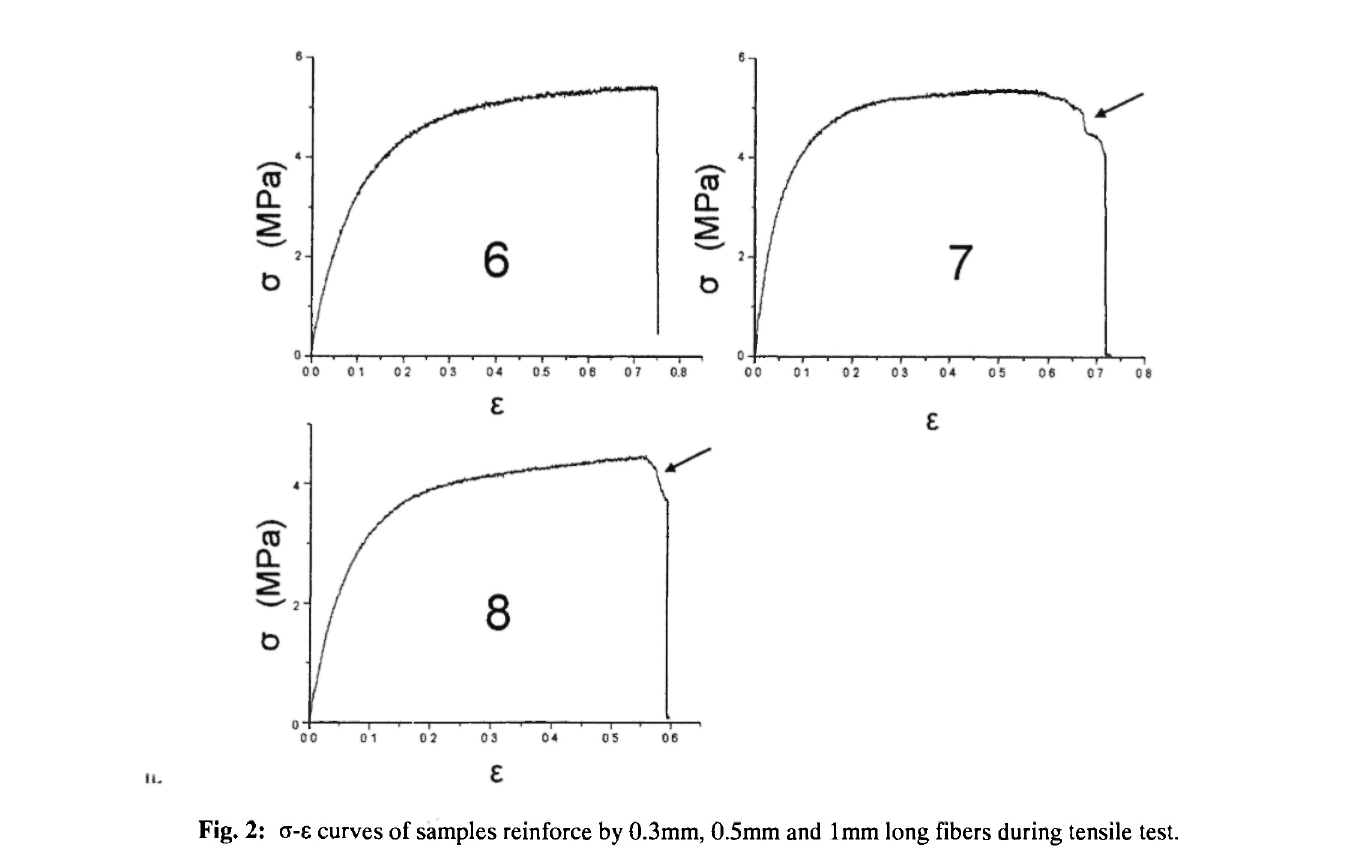
Fig. 2: σ-ε curves of samples reinforce by 0.3mm, 0.5mm and 1mm long fibers during tensile test.